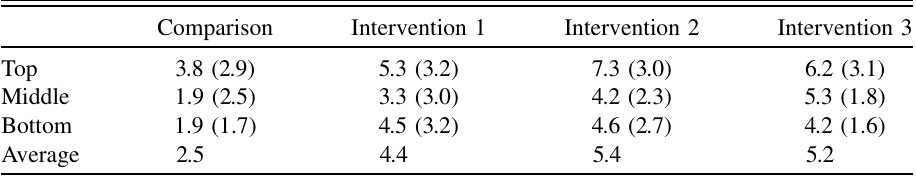
TABLE VIII. Students’ average scores out of 10 on the quiz (transfer) problem in the algebra- based course. Note that the standard deviation in each case is shown in parentheses. The performance of the whole group taken together is represented by an unweighted mean of students’ average scores from the top, middle, and bottom categories.